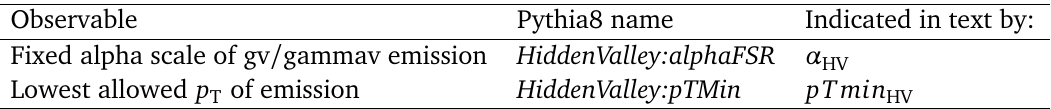
of QCD or α of strong em